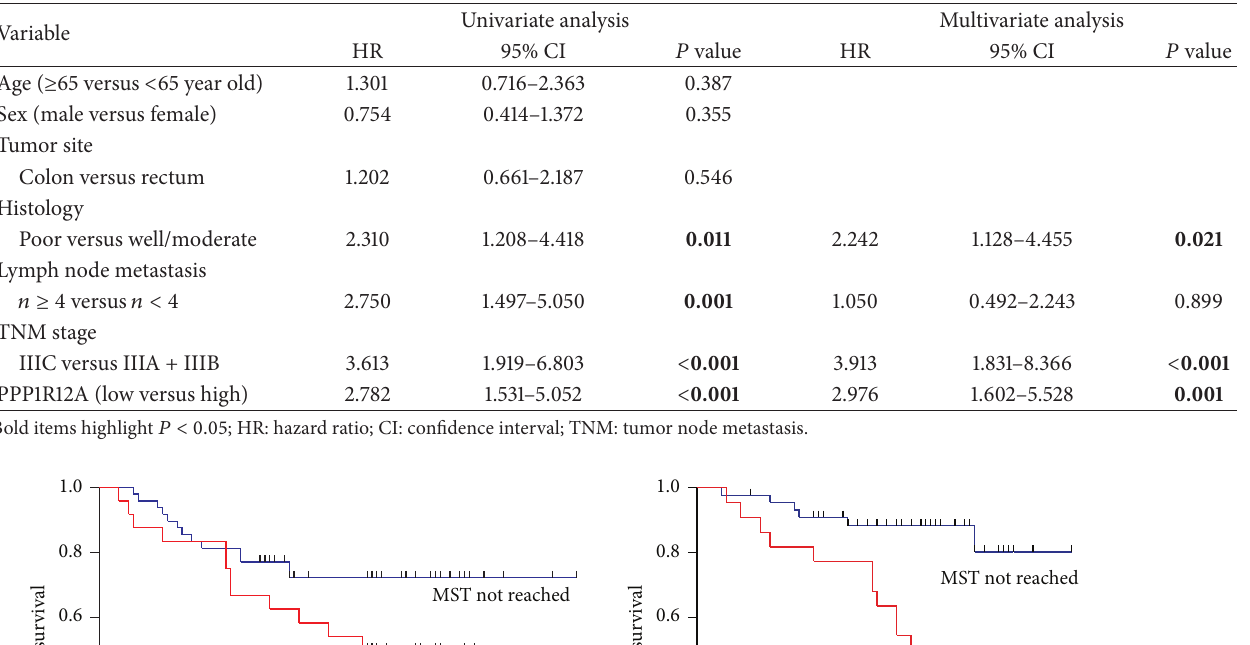
Table 3: Univariate and multivariate analyses for overall survival (Cox proportional hazard model).